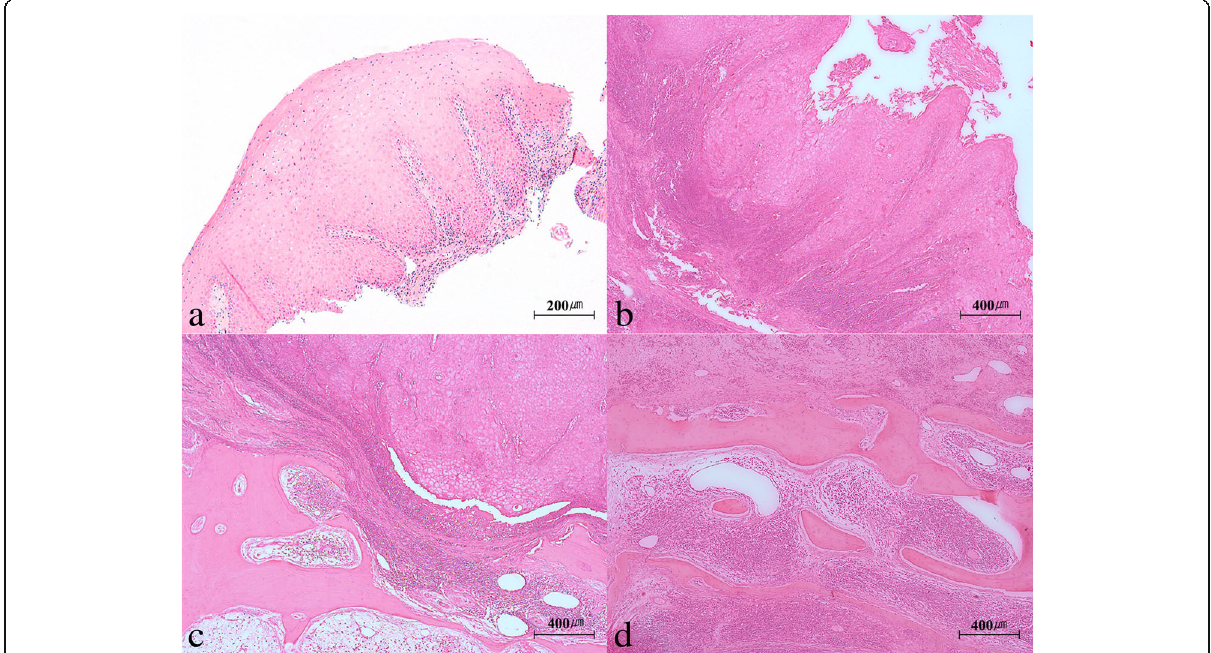
Fig. 8 Histopathologic microphotographs of the specimen with hematoxylin and eosin staining. a Incisional biopsy before surgery showing downward growth of numerous thickened, bulbous rete ridges of squamous cells (× 100). b Surgical specimen showing exophytic growth pattern with prominent keratin layer arranged in compressed invaginating fold (× 50). c Hyperplastic epithelium showing blunt projections rather than infiltration of the underlying tissue with dysplasia and hyperplasia of the basal cell layer (× 50). d A group of epithelial cells proliferating